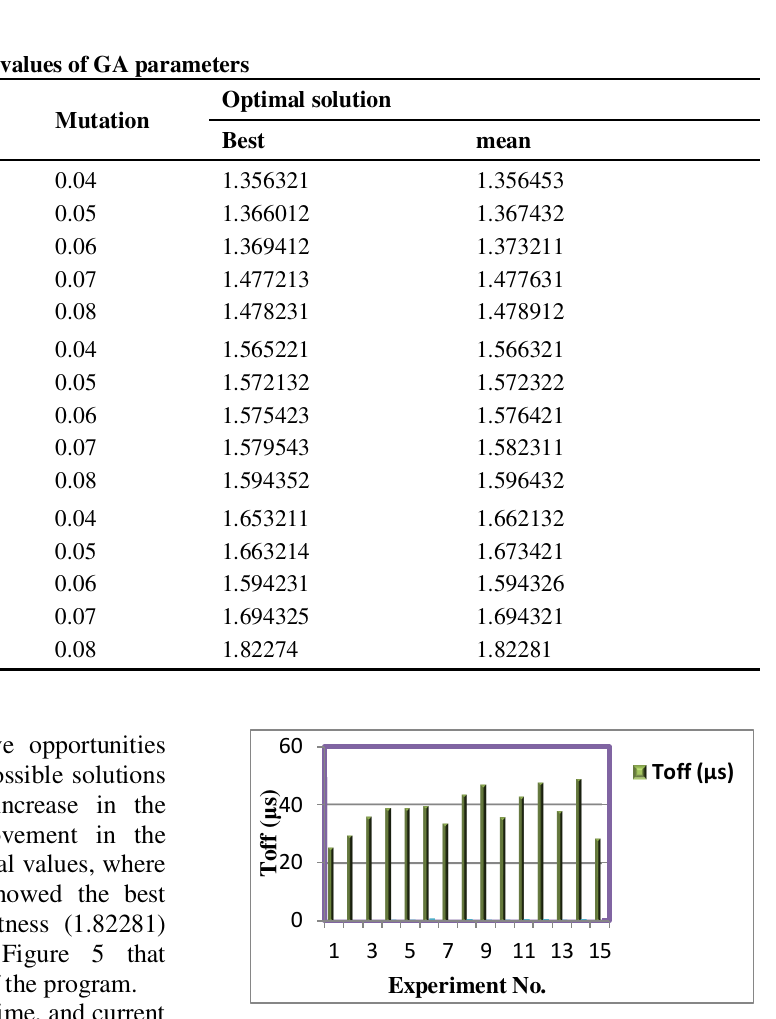
Fig. 6. Effect of pulse off time on MRR.